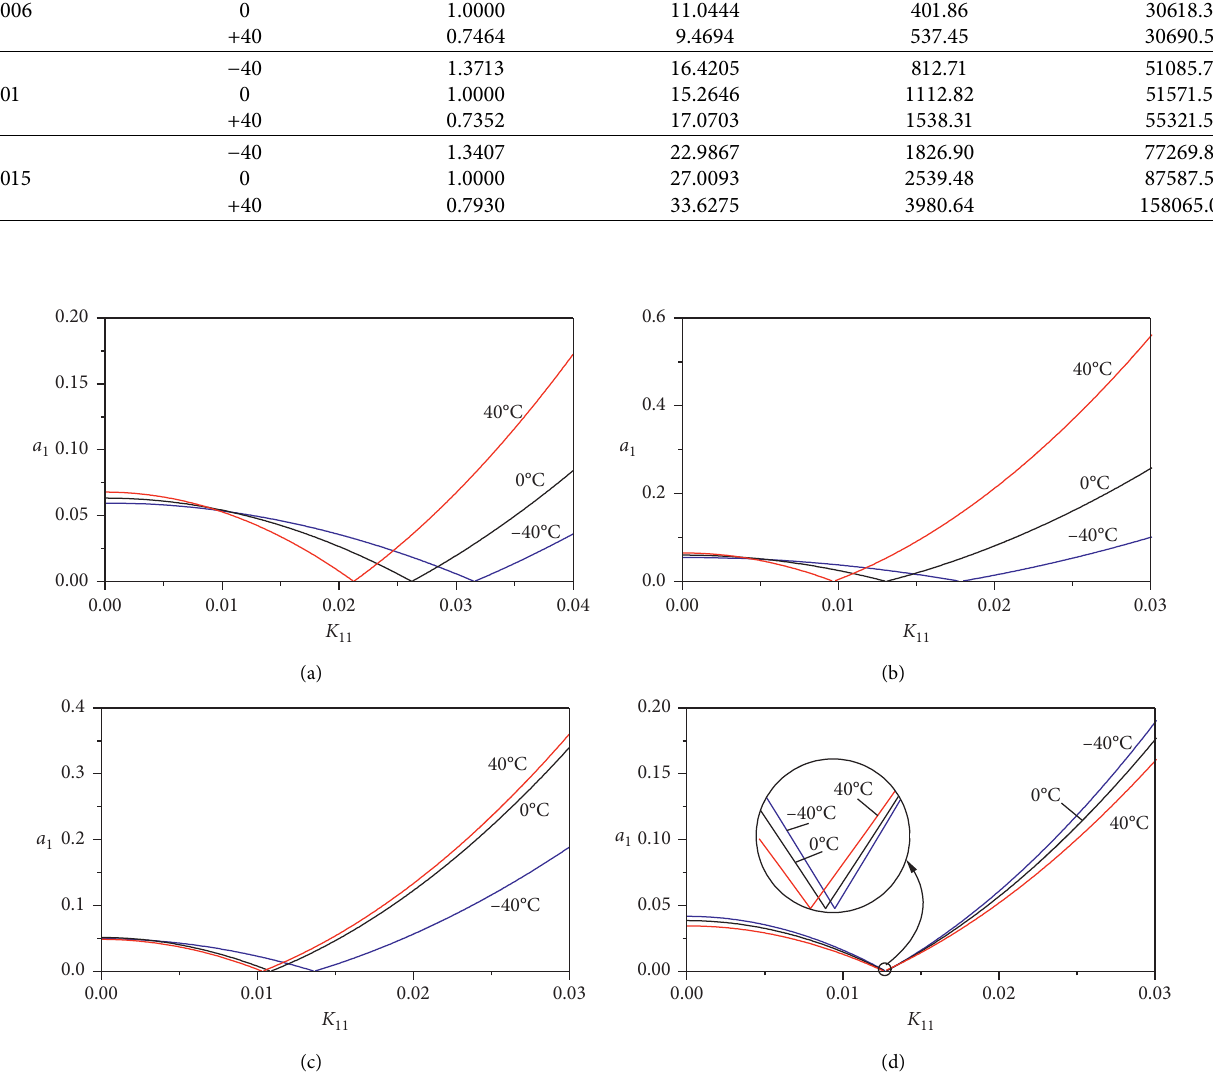
and response amplitude a 11